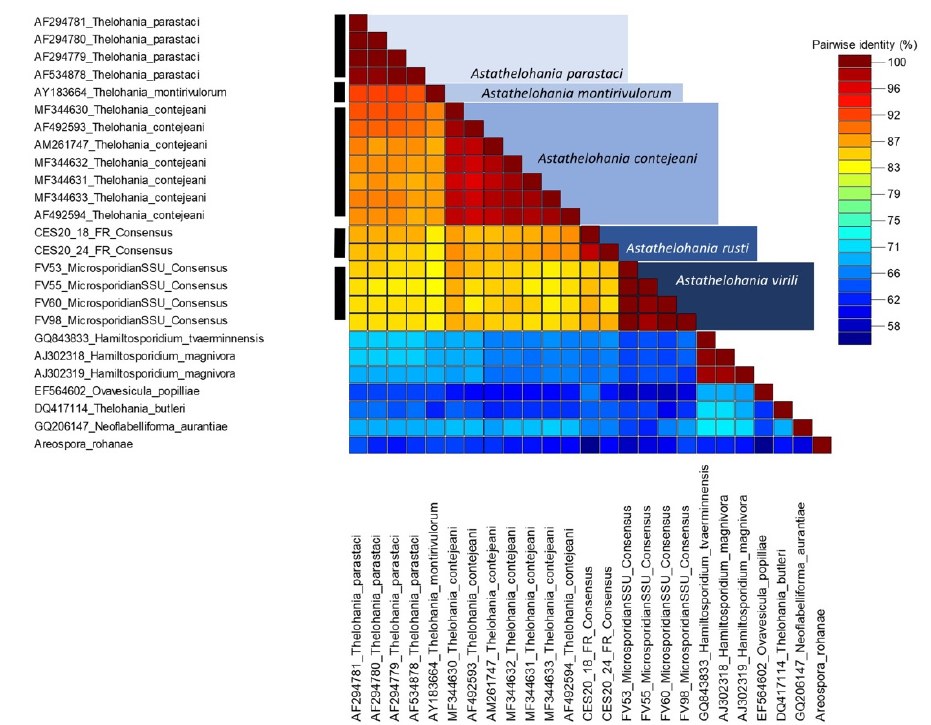
Figure 5. A similarity matrix reflecting the percent similarity between different Astathelohania (= Thelohania ) rRNA (SSU) gene isolates. The key provides a color scheme that reflects the similarity between isolates (blue/low to red/high). The figure was designed using the sequence demarcation Tool v1.2 [35].